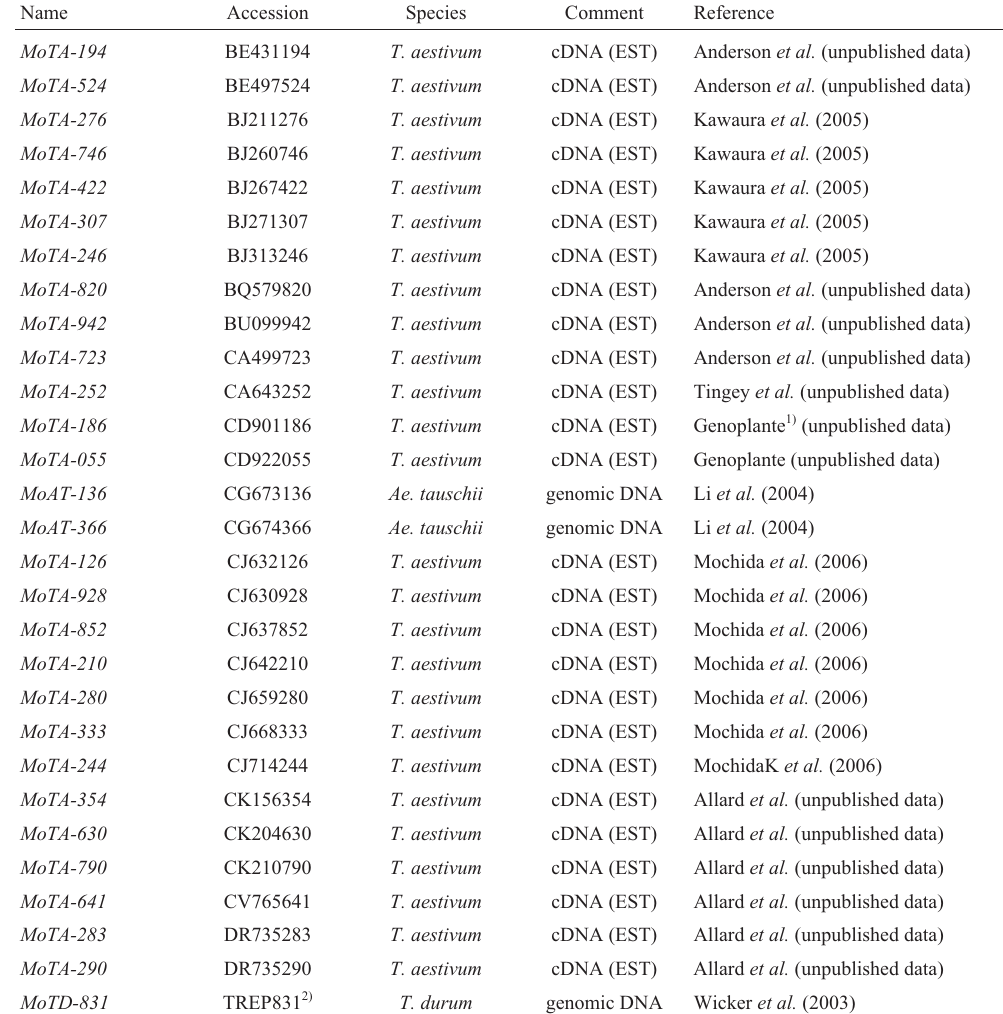
Table 2 - MULE transposases detected in the genera Triticum and Aegilops